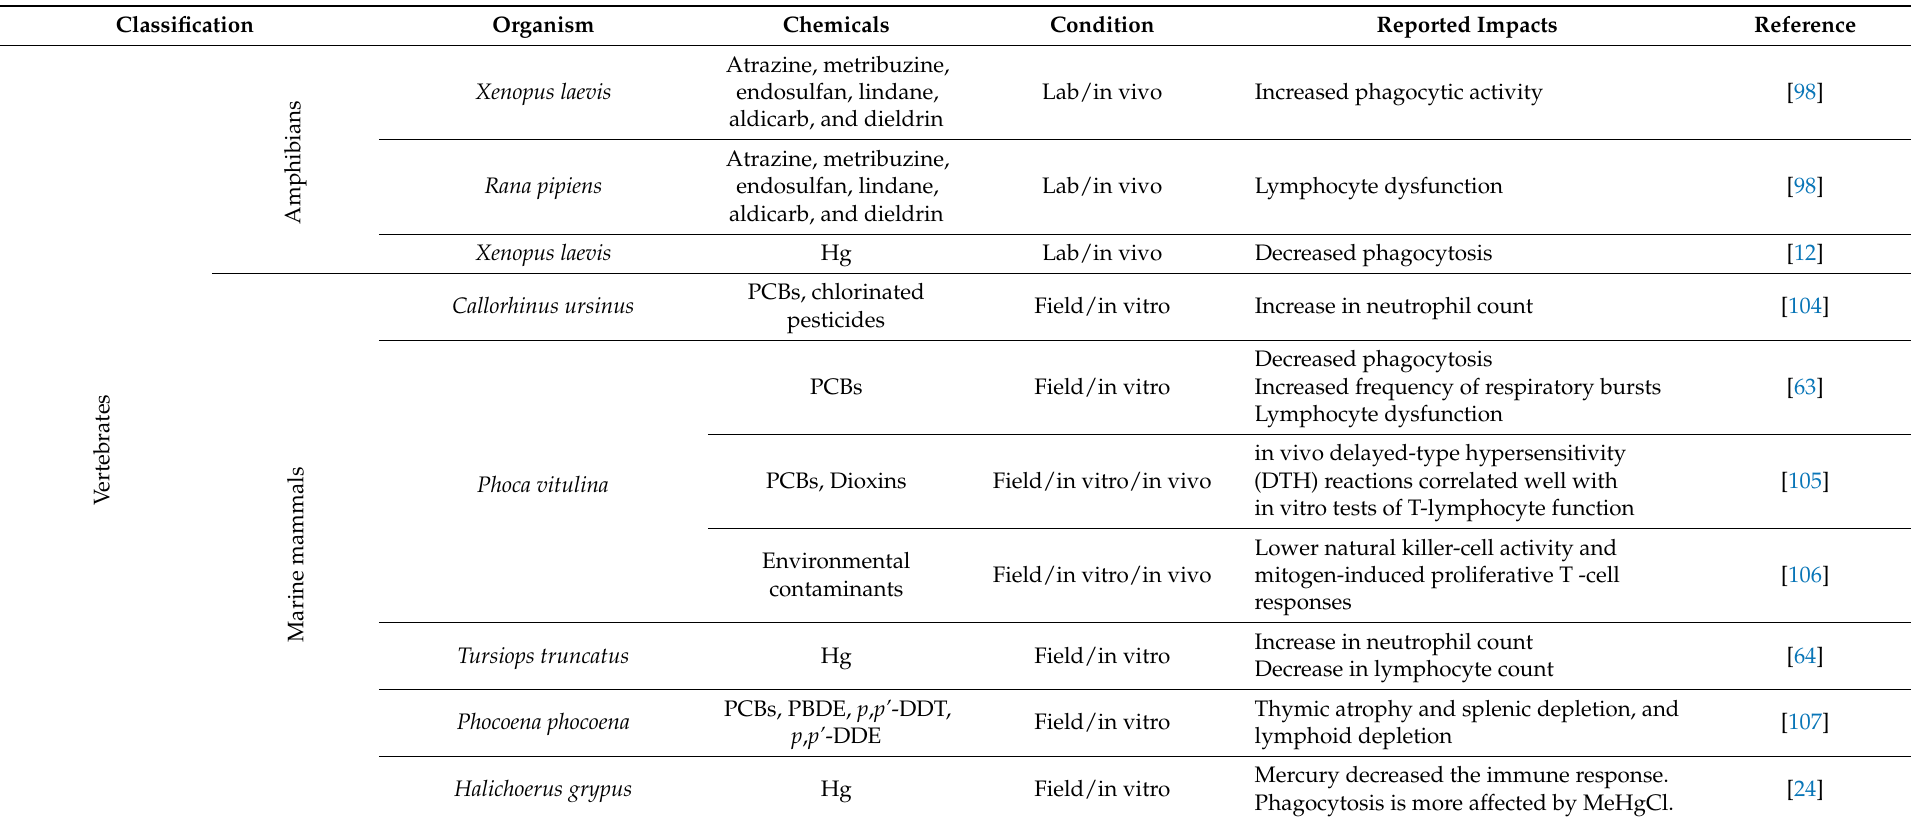
Table 3. Chemical substances that have been reported to have immunotoxic effects in amphibians and marine